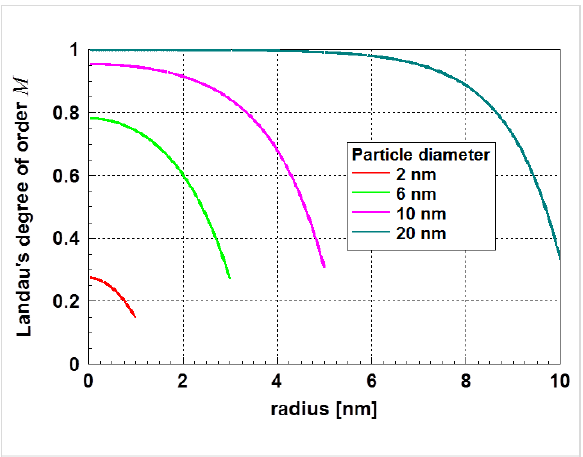
Figure 6: Landau’s order parameter M for tin particles of different par- ticle diameters as function of the radius at a temperature of 440 K. The term “radius” represents the radial distance to the particle center [35].